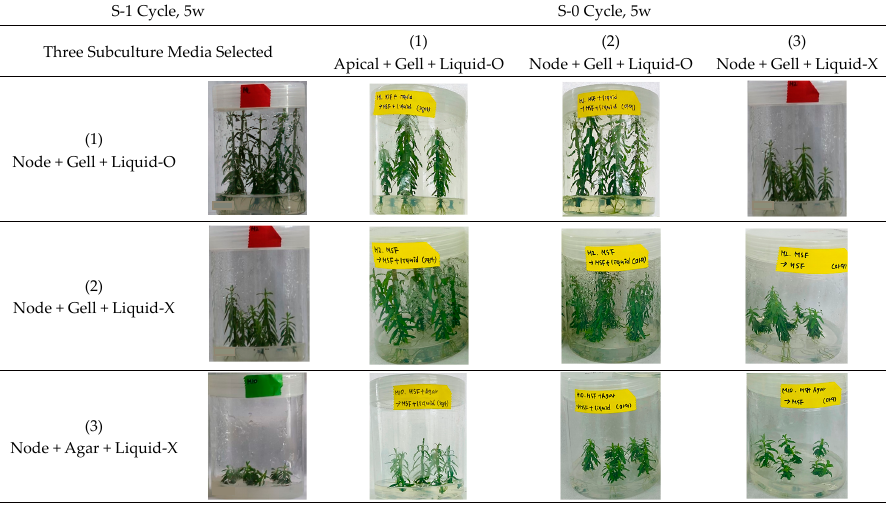
Figure 6. Re- and de-vitalization of donor plantlets of three subculture conditions from the S-1 cycle through the subsequent subculture of three subculture treatments in the S-0 cycle (total of nine states). The growth in the three subculture conditions of the S-1 cycle was significantly changed by the following three conditions of the S-0 cycle. Inoculation of apical sections associated with Gell + Liquid-O in the S-0 cycle (Apical + Gell + Liquid-O) effectively vitalized the slowly grown plantlets from the S-1 cycle (Node + Gell + Liquid-X, Node + Agar + Liquid-X). Whereas non-effective for the vigorously grown plantlets (Node + gell + Liquid-O), which implies that it reached the maximal per- formance in this subculture system. In addition, very slowly grown plantlets in the S-1 cycle (Node + Agar + Liquid-X) did not sufficiently revitalize even with Apical + Gell + Liquid-O in S-0, which means additional subculture cycles are needed to restore the plant- lets before cryopreservation.